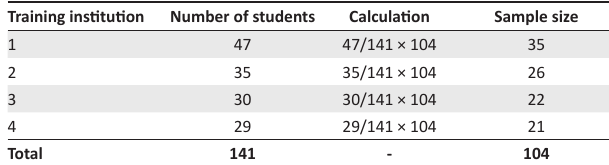
TABLE 1: Sample size